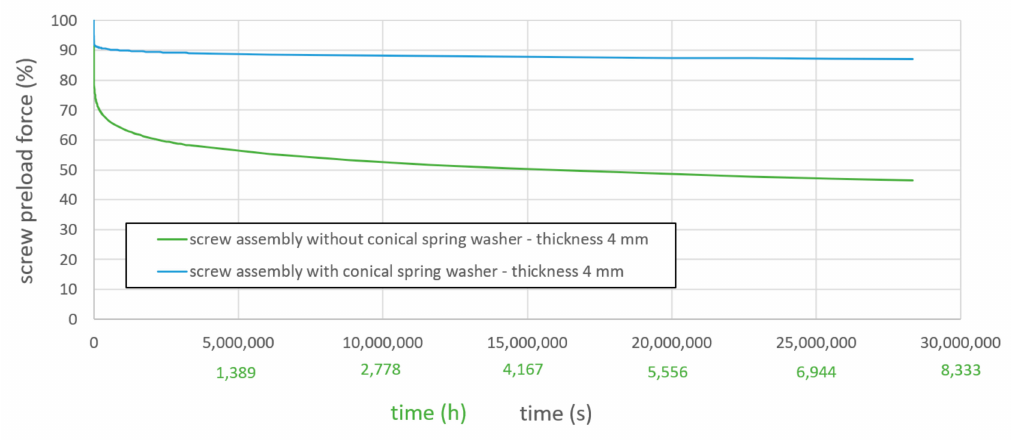
Figure 10. Simulated screw preload force over time of application-oriented screw